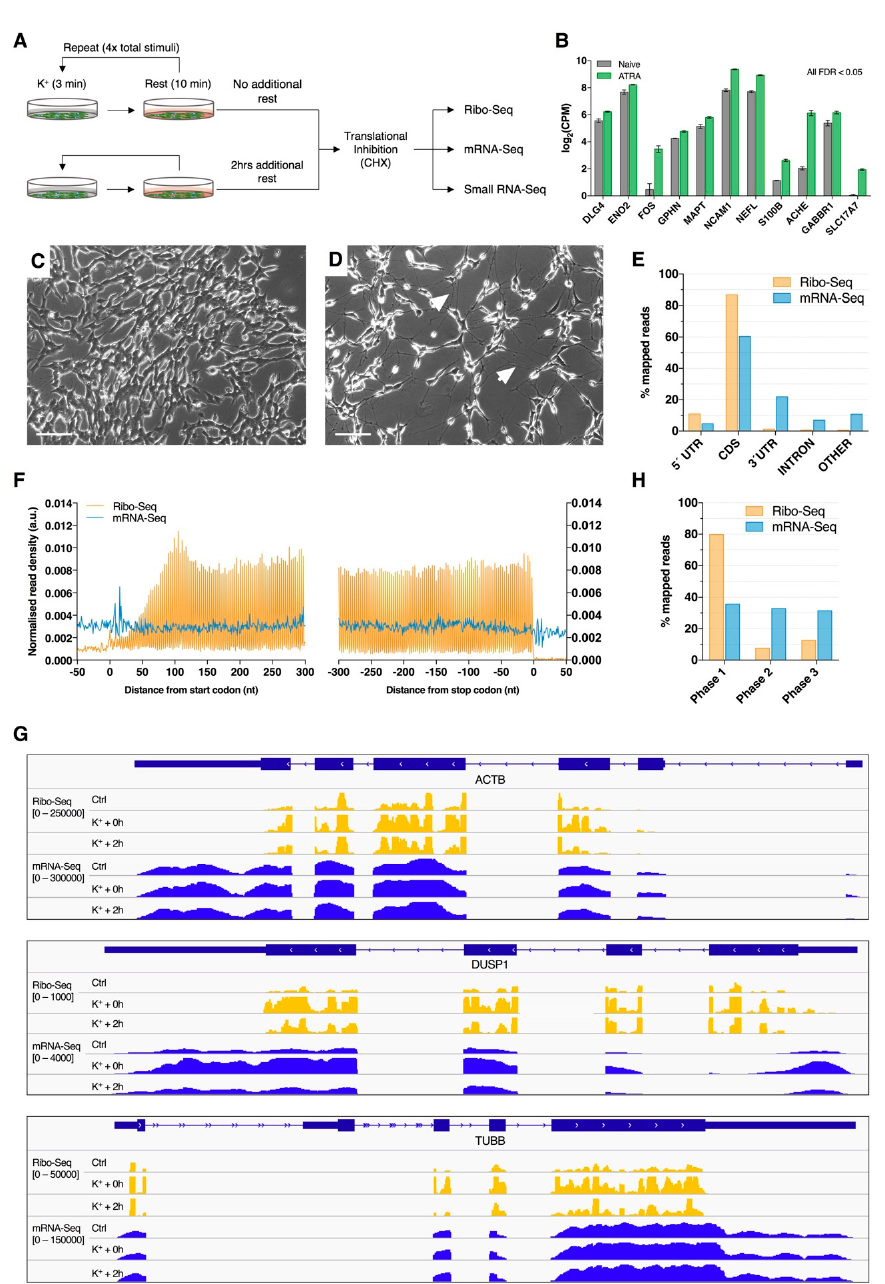
Figure 1. Ribosome profiling of neuronally differentiated K + depolarized SH-SY5Y cells. ( A ) Schematic overview of the membrane depolarization paradigm employed in this study. ( B ) Expression of known neuronal marker genes in ATRA-treated SH-SY5Y cells (7 days) relative to naïve cells from a previous study. All genes were subjected to statistically significant upregulation (FDR < 0.05). ( C,D ) Phase contrast images of naïve ( C ) and ATRA-treated ( D ) SH-SY5Y cells. Note the change in cellular morphology and extensive neurite development after ATRA treatment (white arrows). Scale bar = 100 µ m. ( E ) Percentage of Ribo-Seq and mRNA-Seq reads aligning to transcriptome features. Composite data are shown after merging biological replicates and treatment groups. ( F ) Metagene analysis of read density around transcript start and stop codons, showing high ribosome-protected mRNA fragment (RPF) density between coding sequence (CDS) start and stop codons. RPF reads were calibrated to estimated P-sites (see supplementary methods for further details). ( G ) Screenshots of RPF (orange) and mRNA (blue) read depth (RPKM) for representative genes: ACTB, DUSP1 and TUBB. ( H ) Sub-codon phasing of RPF and mRNA reads, revealing that RPFs exhibit a preference for the first canonical reading frame, whereas mRNA-Seq data displays comparatively even distribution across all three